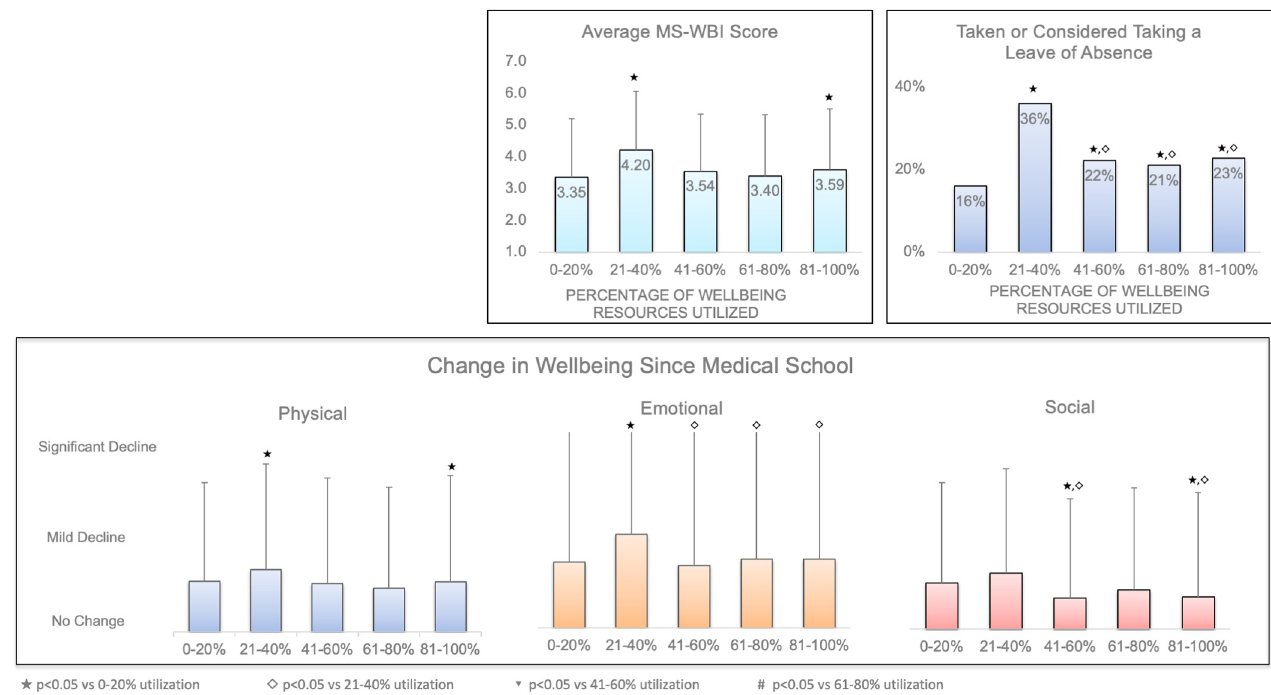
Fig 2. Impact of wellbeing resources utilization on student distress. Average MS-WBI and percentage of students who had taken or considered taking a leave of absence for personal wellbeing based on self-reported utilization rate of wellbeing resources (Mental Health & Counseling Services, Peer Mentorship, Self-Care Education, Mindfulness/Meditation Classes, and Community Building Events Mental Health) by survey respondents. Utilization rates were calculated based only on resources marked as offered by students. Average change in students’ physical, emotional, and mental well-being based on the number of wellbeing resources offered. Error bars represent standard deviation, p-value vs. 1, 2, 3 and 4 wellbeing resources noted in key.